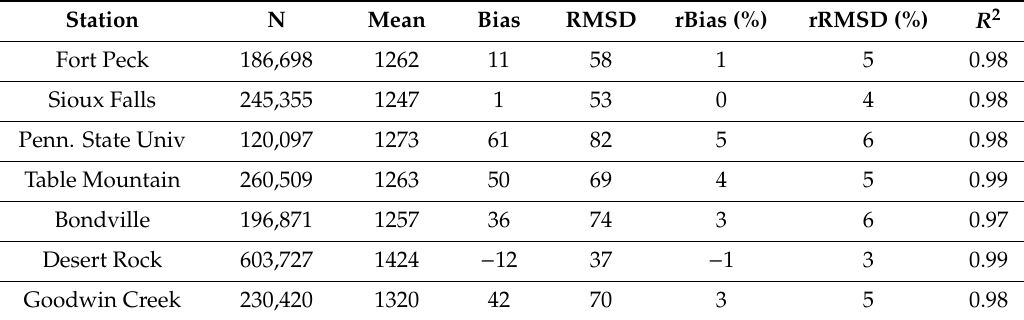
Table 3. Statistics of comparison between the measured global PPFD and estimates. N is the number of data pairs.